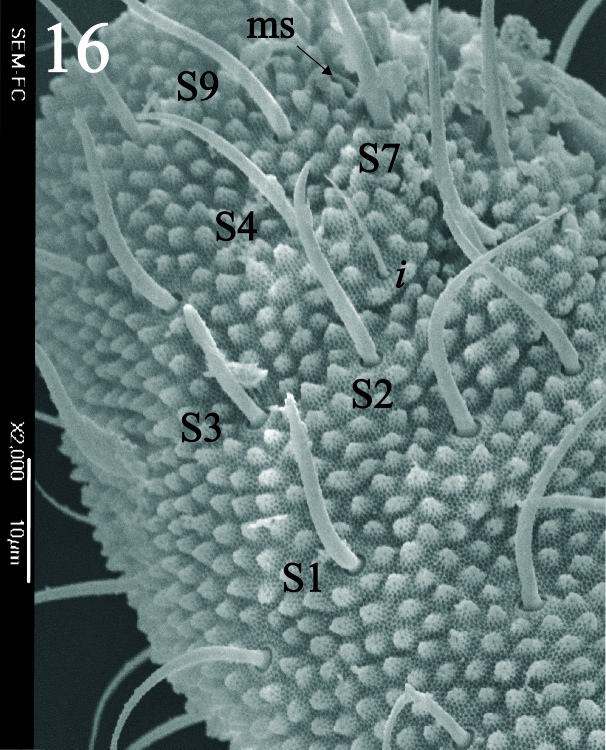
Ant IV dorsal view.